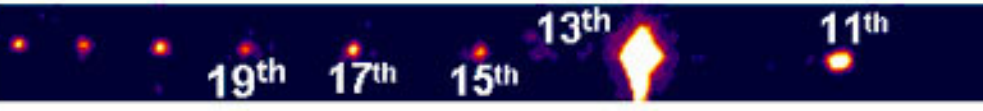
Figure 6. Spectrum of the high-order harmonic generation was obtained using the indium plasma. The pulse energy of the 13th harmonic is about 1 μ